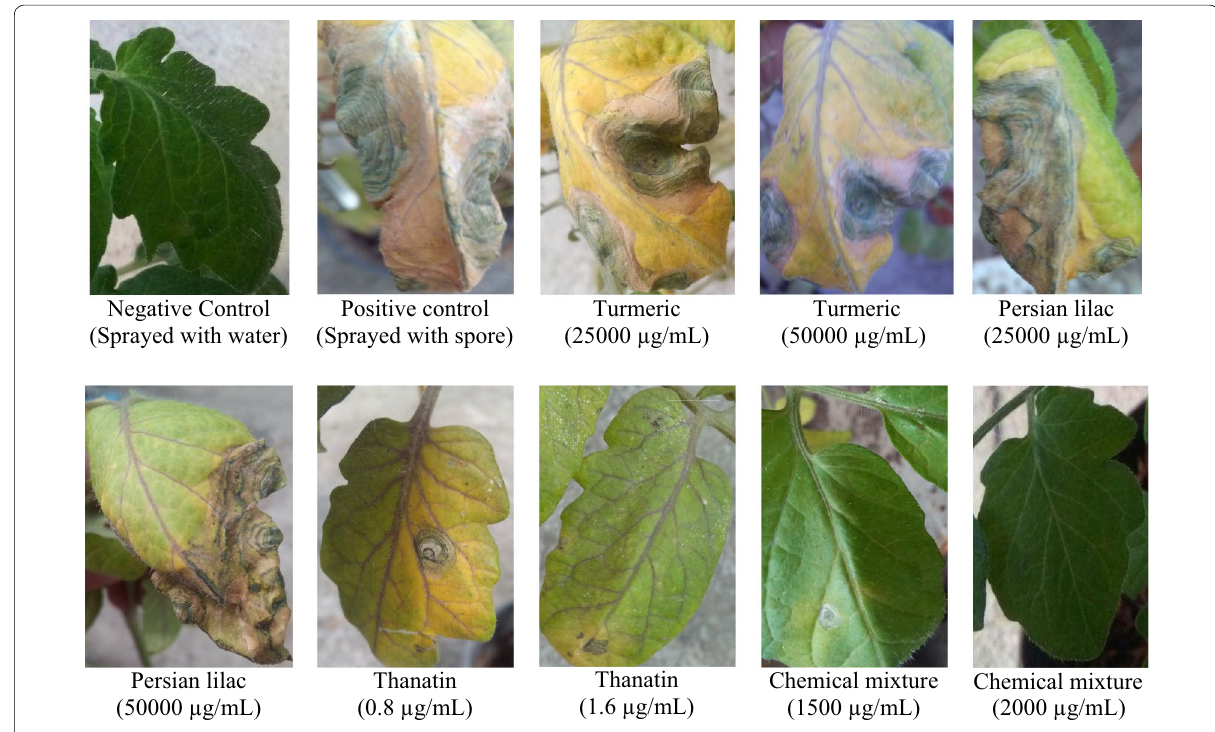
Fig. 7 The response of different pretreated tomato plants 15 days after leaf inoculation by A. tenuissima